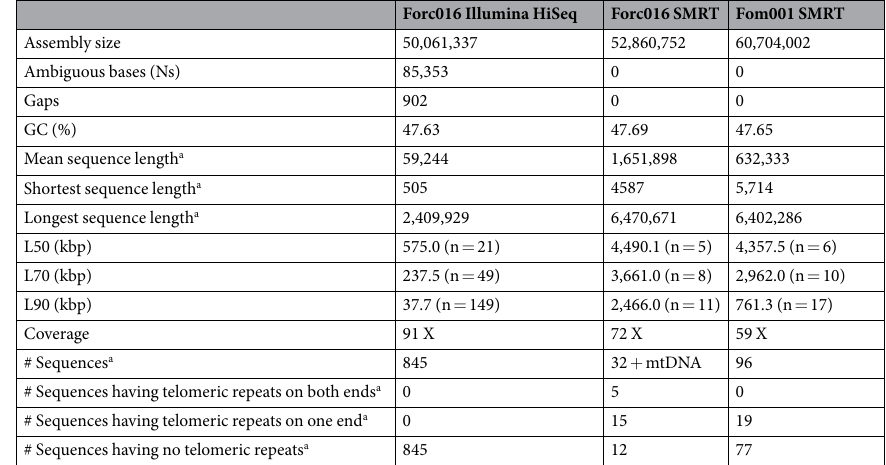
Table 1. Comparison of the Forc016 genome assembly generated with Illumina HiSeq 2500 reads with the manually corrected SMRT HGAP.3 assembly and the raw SMRT HGAP.3 assembly of Fom001. a ‘Sequences’ refers to scaffolds (Illumina assembly) or contigs (SMRT